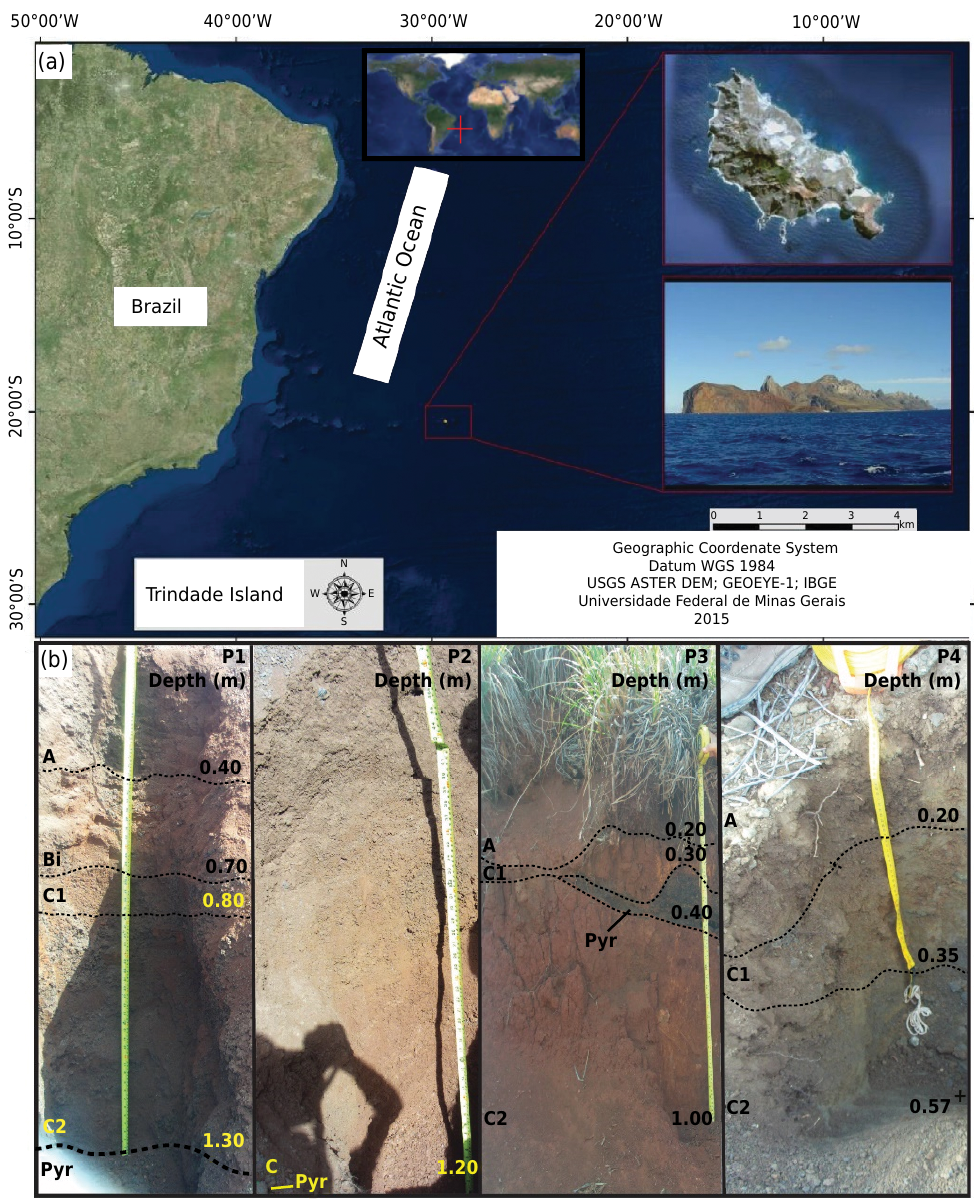
Figure 1. Location of Trindade Island in the South Atlantic Ocean (a). Elaborated by Mariana Rezende Machado. Location of profiles in VP (P1) and MV formations (P2, P3, and P4) and description of pedological horizons. Modified of Mateus et al. (2018) (b). A: A horizon; Bi: Bi horizon; C1: C1 horizon; C2: C2 horizon; Pyr: